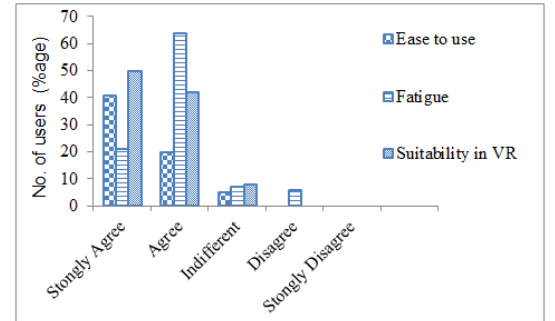
Fig. 18: Subjective analysis of the three factors